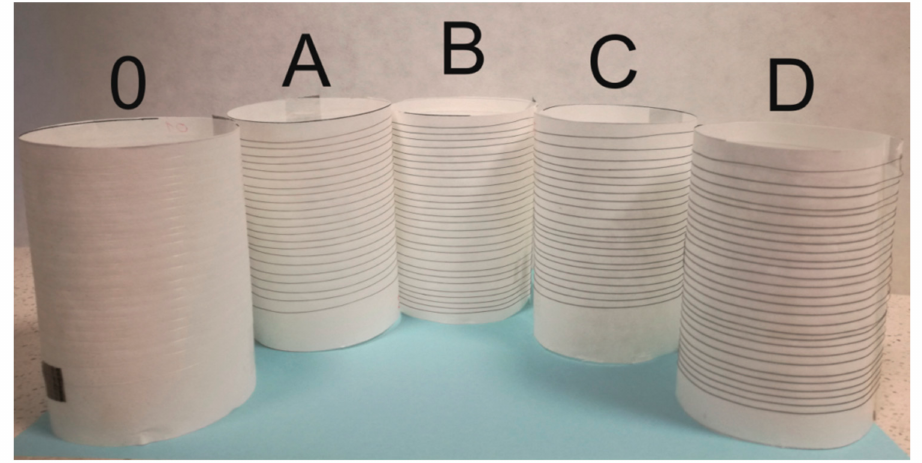
Figure 2. The photo shows pure cellulose fibres ( 0 ) and GO/CEL composite fibres ( A – D ). The ob- tained fibres look identical, regardless of the coagulation method (water-1;